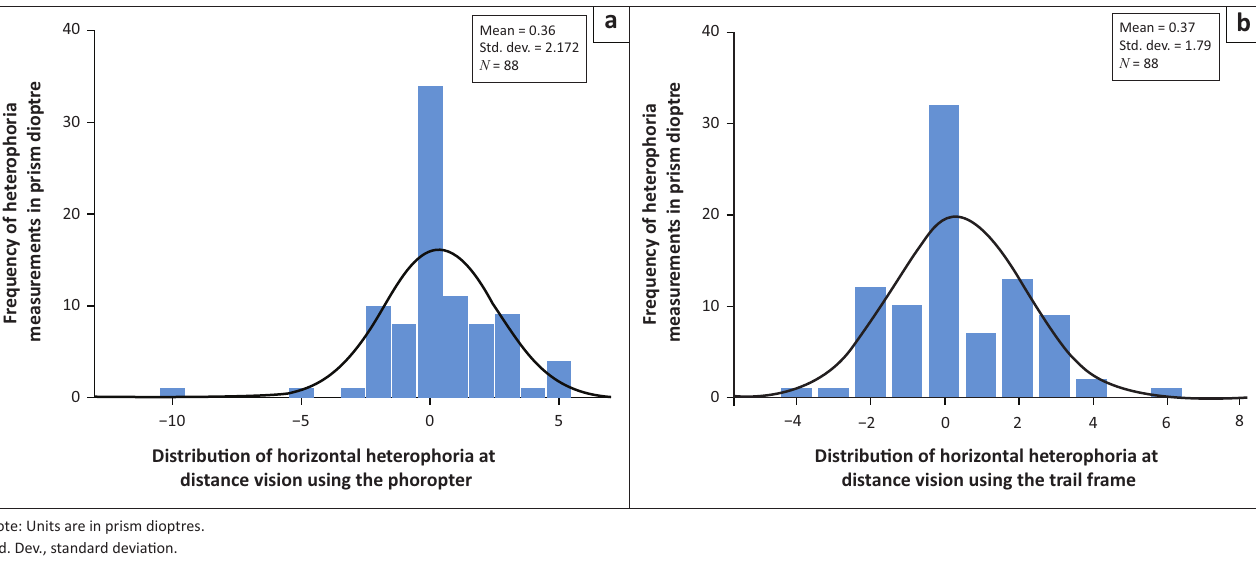
FIGURE 2: Histograms for distance horizontal heterophoria using the phoropter (a) and trial frame (b)